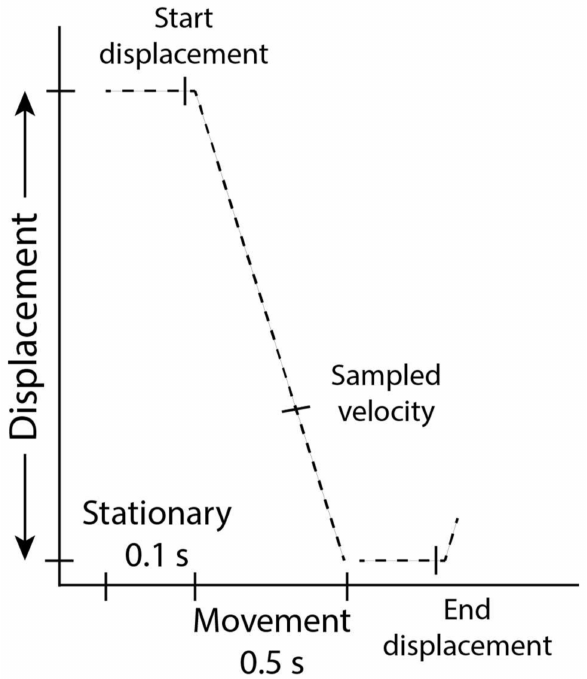
Figure 2. Scheme for the set motion of the transducer and the frames used for determining displacement and velocity. The displacement of each kernel was calculated as the difference between its position in the start and end frames. The velocity was estimated as the difference between two consecutive